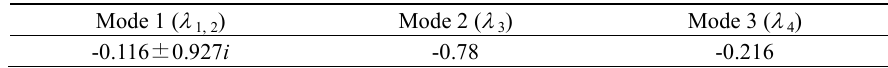
Table 2 Eigenvalues of the system matrix